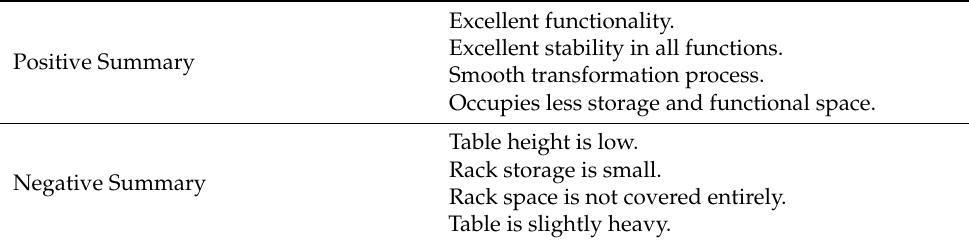
Table 22. Summary of unstructured feedback